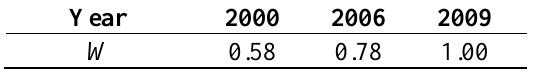
Table 3. Security demand fluctuation factor in Guangzhou.